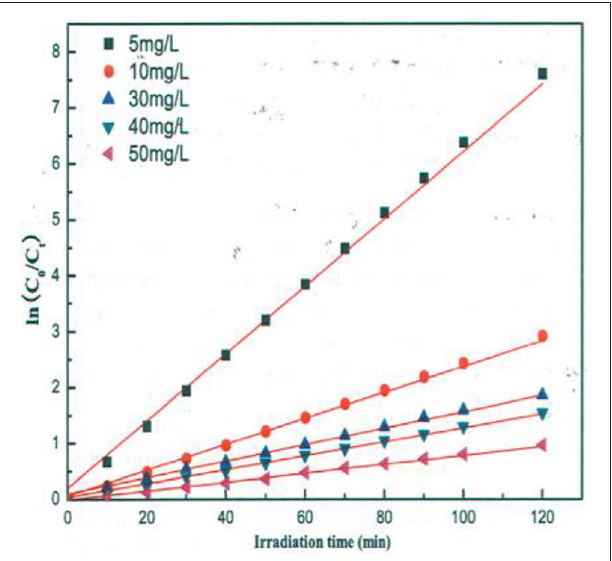
FIGURE 3 | Kinetics of methyl orange degradation catalyzed by ZnO nanoparticles (Chen et al., 2011; Reproduced by permission).